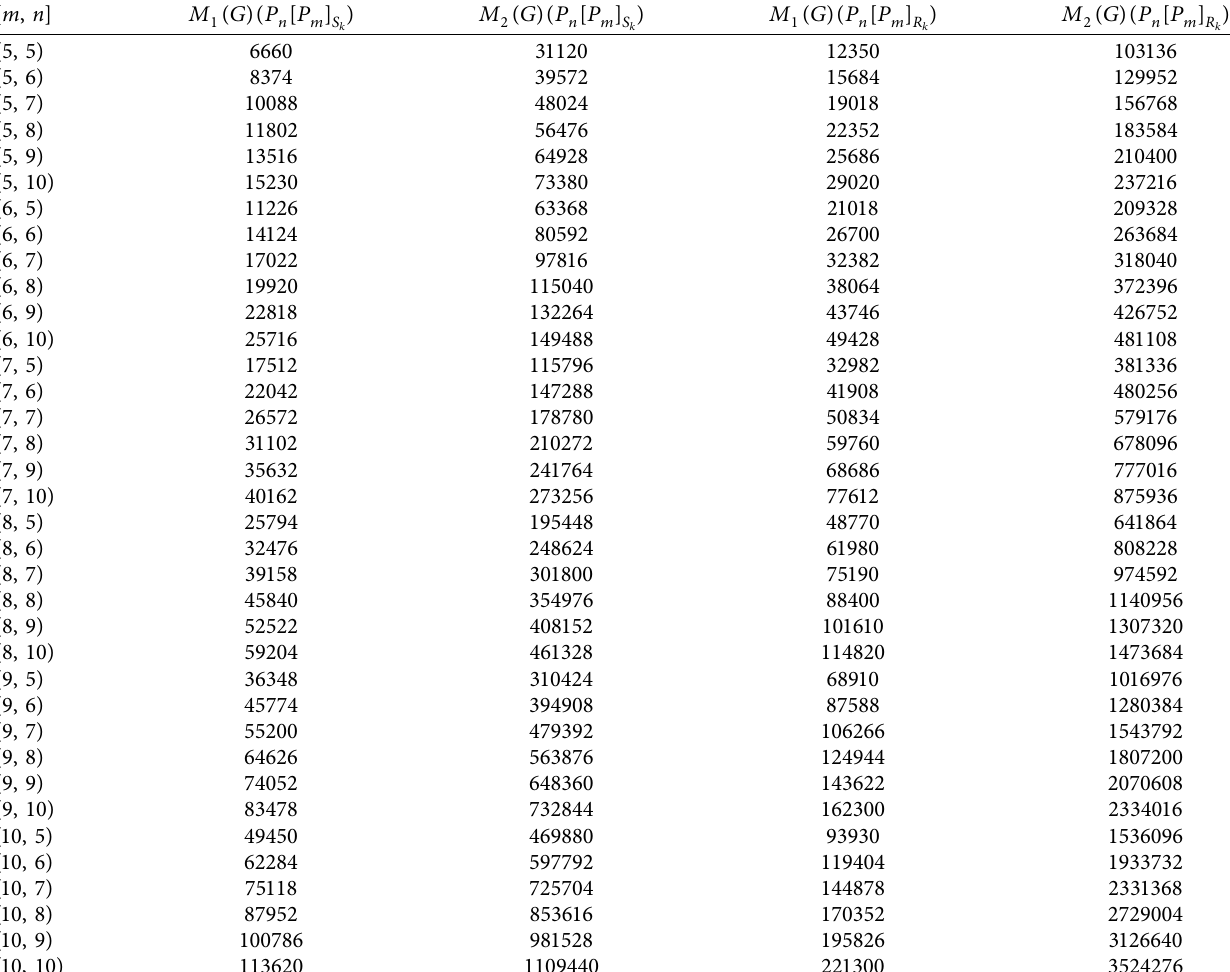
[ P ] ) for k � 2. n m N k